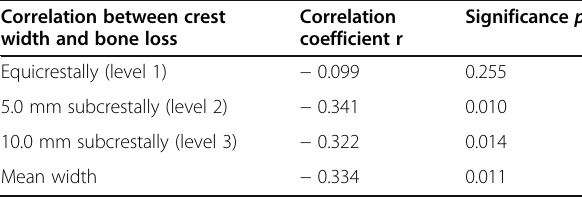
Table 2 Correlation between MBL and alveolar crest